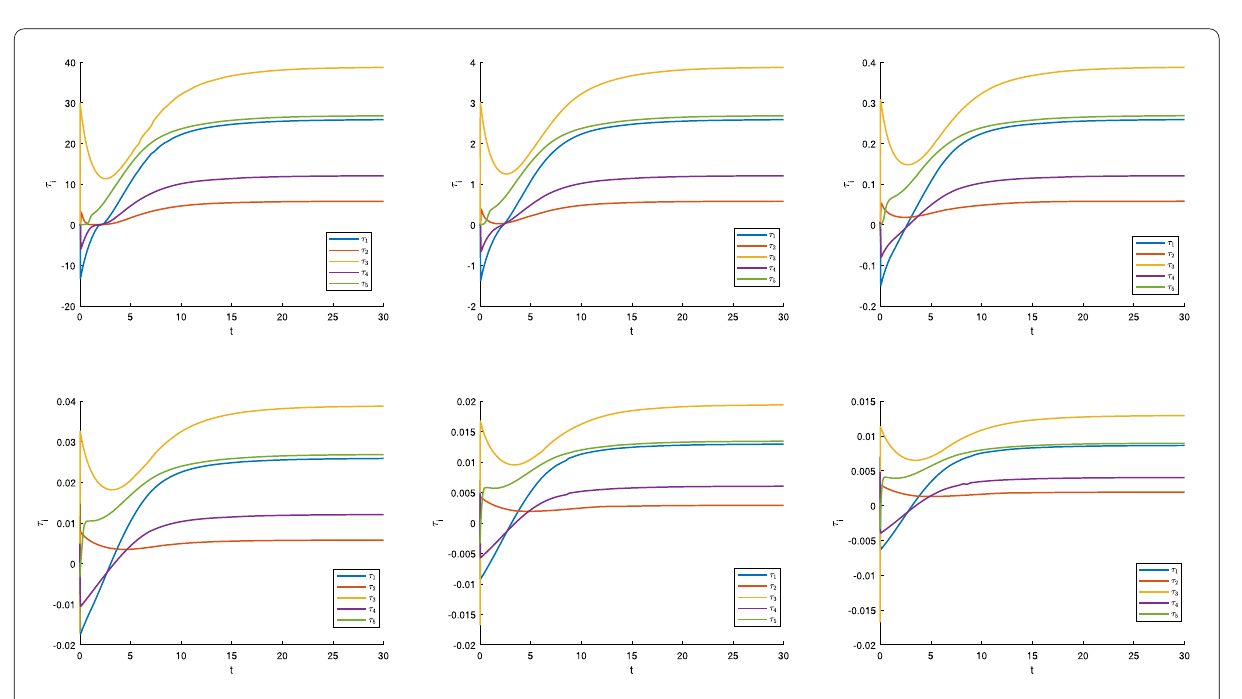
gorithm. Next, we present numerical simulations to verify the